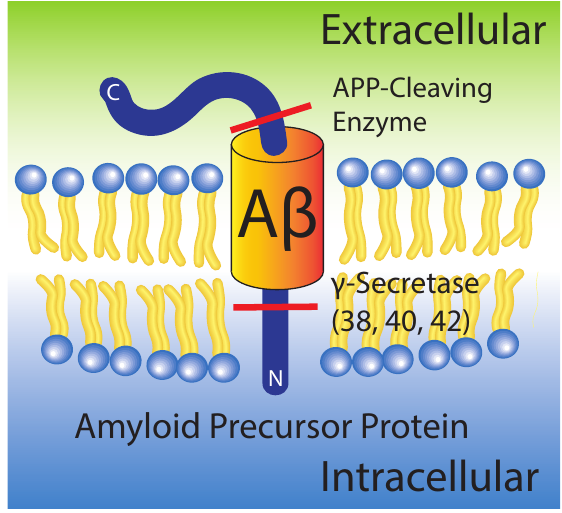
Figure 1. Schematic of amyloid precursor protein in its “original” position within the membrane prior to cleavage and release of intra- and extracellular fragments. Amyloid- β (A β ) is initially in the external leaflet of the membrane, where it only slightly perturbs the